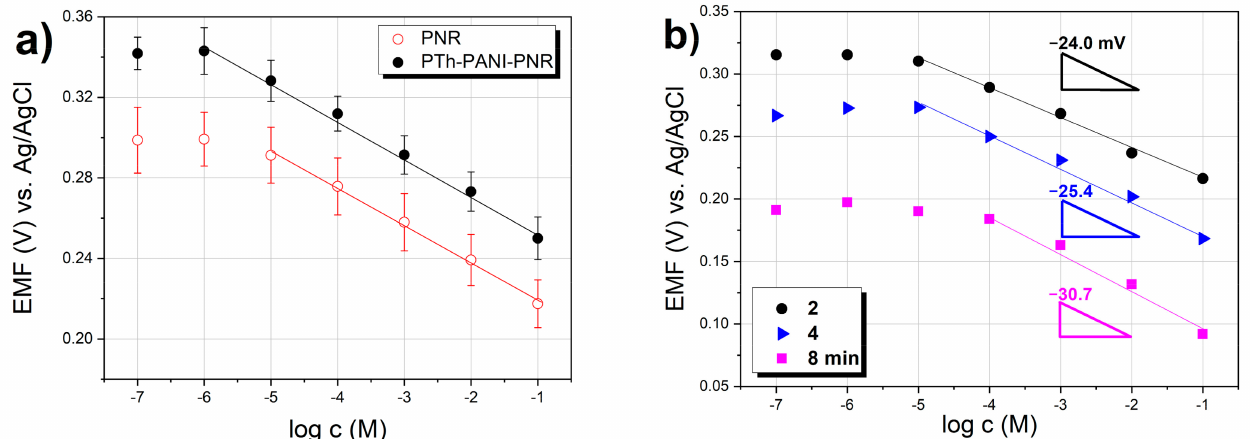
Figure 7. Potential response of modified PNR electrodes toward citrates in TRIS buffer with KNO 3 ( a ) comparison of PNR and three-layer electrodes (PTh-PANI-PNR), ( b ) influence of the thickness (deposition time) of PTh